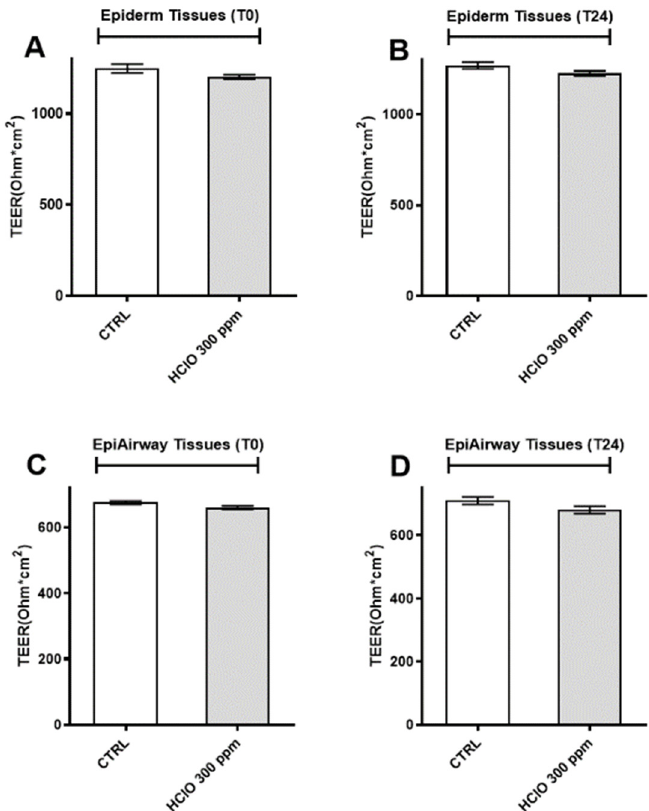
Figure 8. Effects of HOCl nebulization on Epiderm and Epiairway barrier function. ( A , B ) TEER value of Epiderm tissue immediately after, and after 24 h of 300 ppm HOCl nebulization. ( C , D ) TEER value of Epiairway tissue immediately after, and after 24 h of 300 ppm HOCl nebulization. Data are expressed as mean ± SEM of four different experiments.